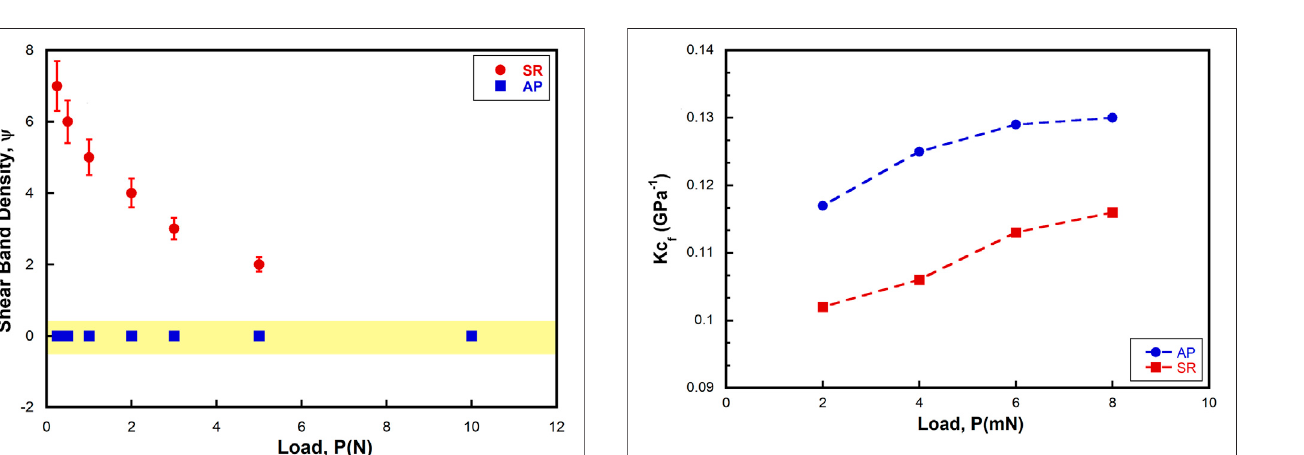
FIGURE 8 | Variation of the shear band density, ψ (number of shear bands on the indented surface), with maximum indentation load, P max , for both the SR and AP NGs.